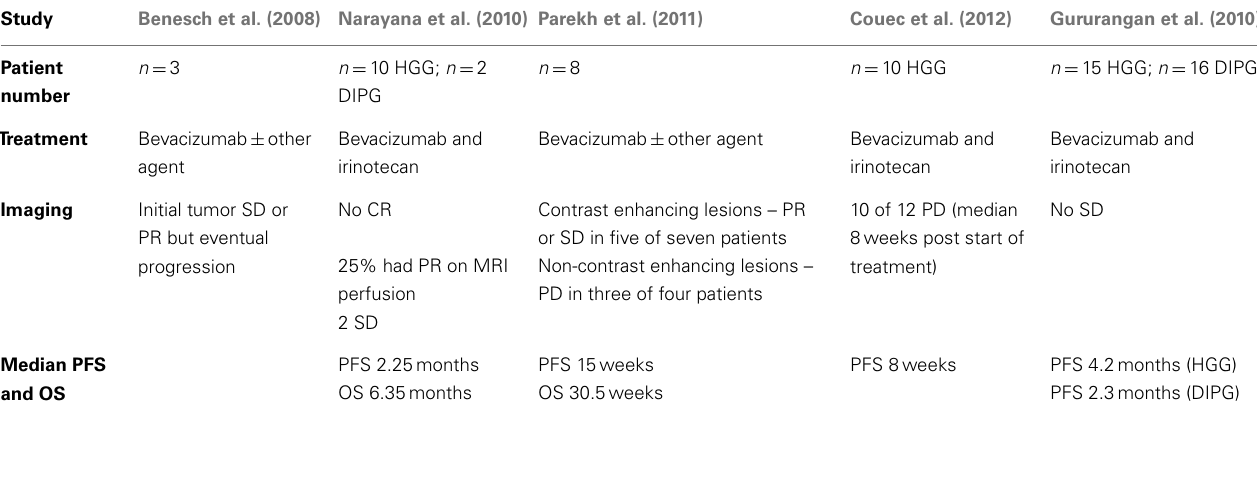
Table 1 | Efficacy results for high-grade